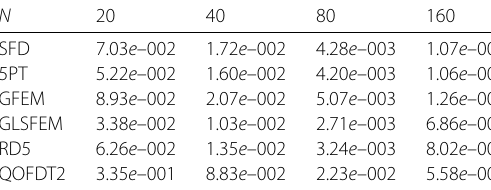
Table 1 Errors of different second-order schemes ( k = 10)